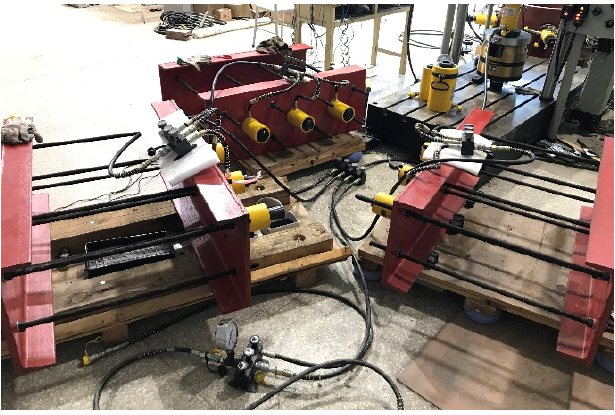
Figure 5. Diagram of synchronous pulsation fatigue loading device.